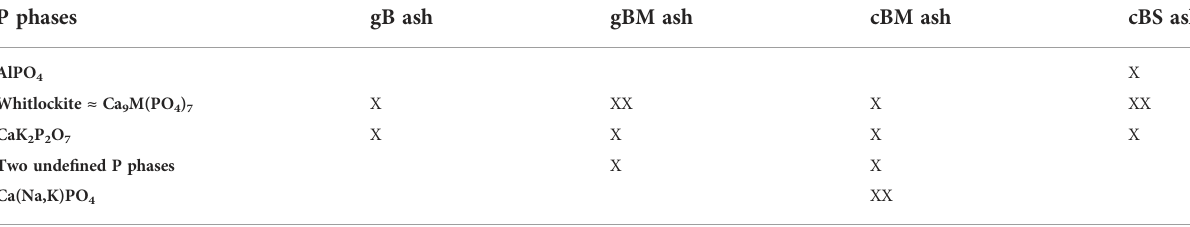
TABLE 3 Overview of crystalline P phases in gB, gBM, cBM and cBS ashes based on Supplementary Material S7 . P